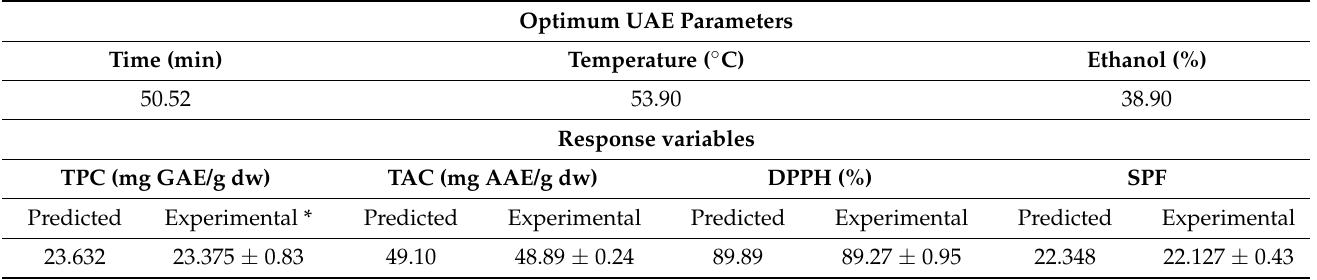
Table 5. Estimated optimal conditions: predicted and experimental values of investigated